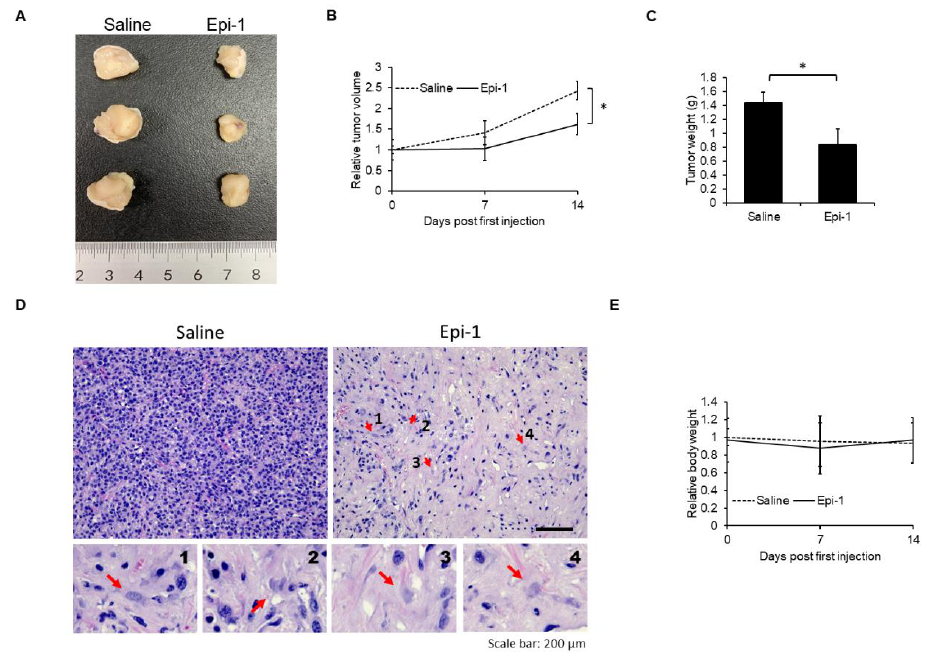
Figure 7. Effect of epi-1 on a subcutaneous synovial sarcoma mouse xenograft model. Xenograft tumor size (length unit: centimeter) ( A ), relative tumor volume ( B ), tumor weight ( C ), H&E analysis of tumors ( D ), and relative body weight ( E ) after epi-1 or saline treatment. Red arrows indicate karyolytic cells. Magnified pictures of indicated karyolytic cells are shown in the lower images. Scale bar: 200 μm. Significance was determined by one-way ANOVA. * p < 0.05 was considered significant.